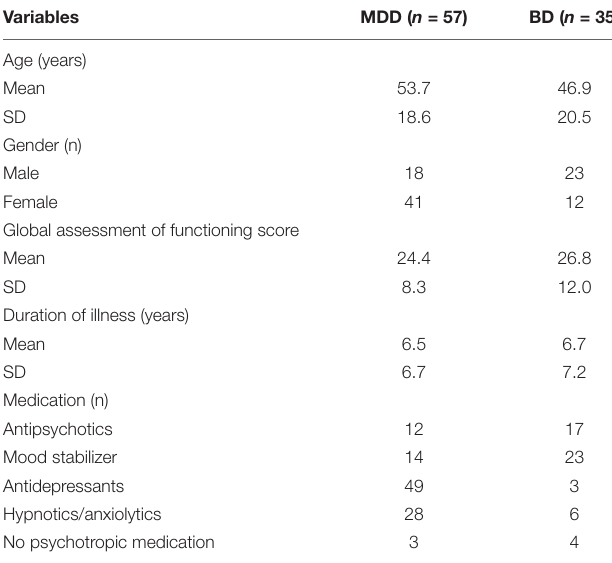
TABLE 1 | Demographic and clinical characteristics of the